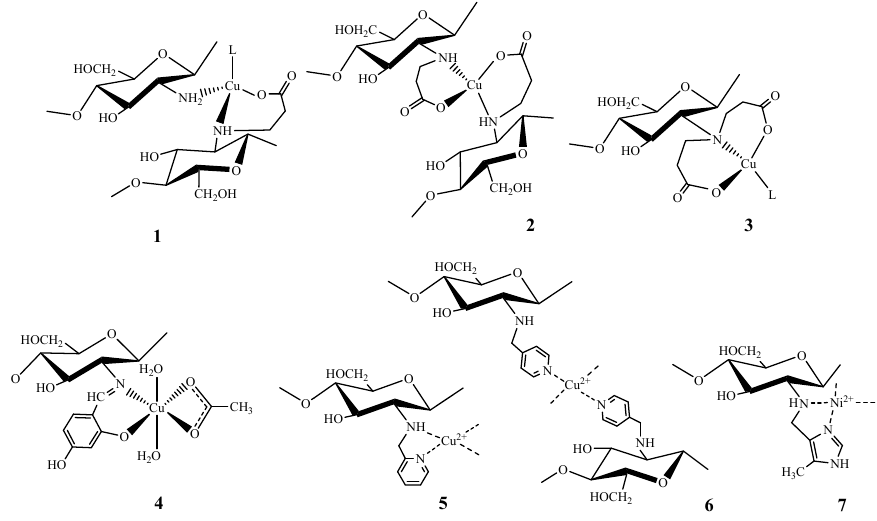
Figure 11. Suggested structures of complexes with N -(2-carboxy)ethyl chitosans, 1 – 3 —from [46]; with N -(4-hydroxysalicylidene) chitosan, 4 —from [151]; with N -(2-pyridyl)methyl and N -(4-pyridyl)methyl chitosan), 5, 6 —from [115]; with N- (5-methyl-4-imidazolyl)methyl chitosan, 7 from [82].